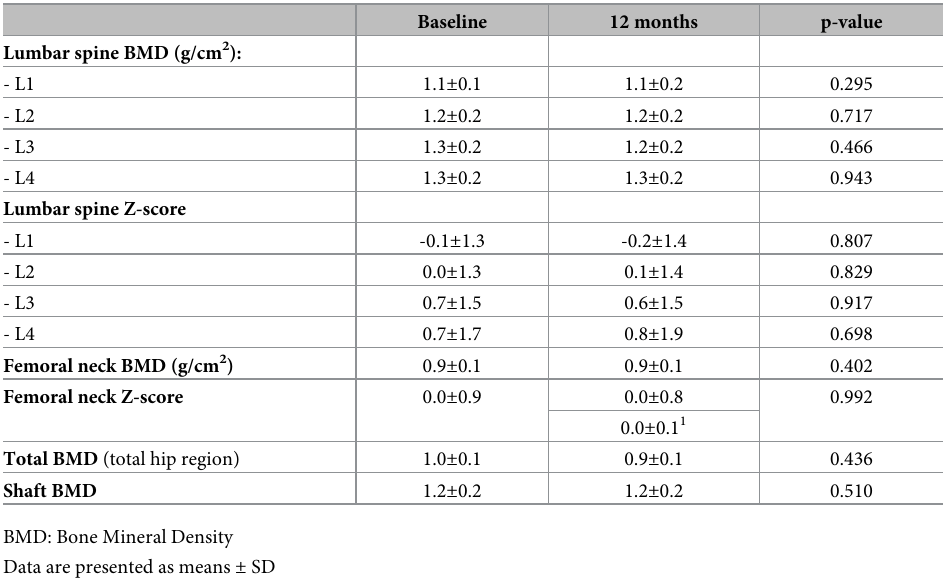
Table 4. DEXA parameters in